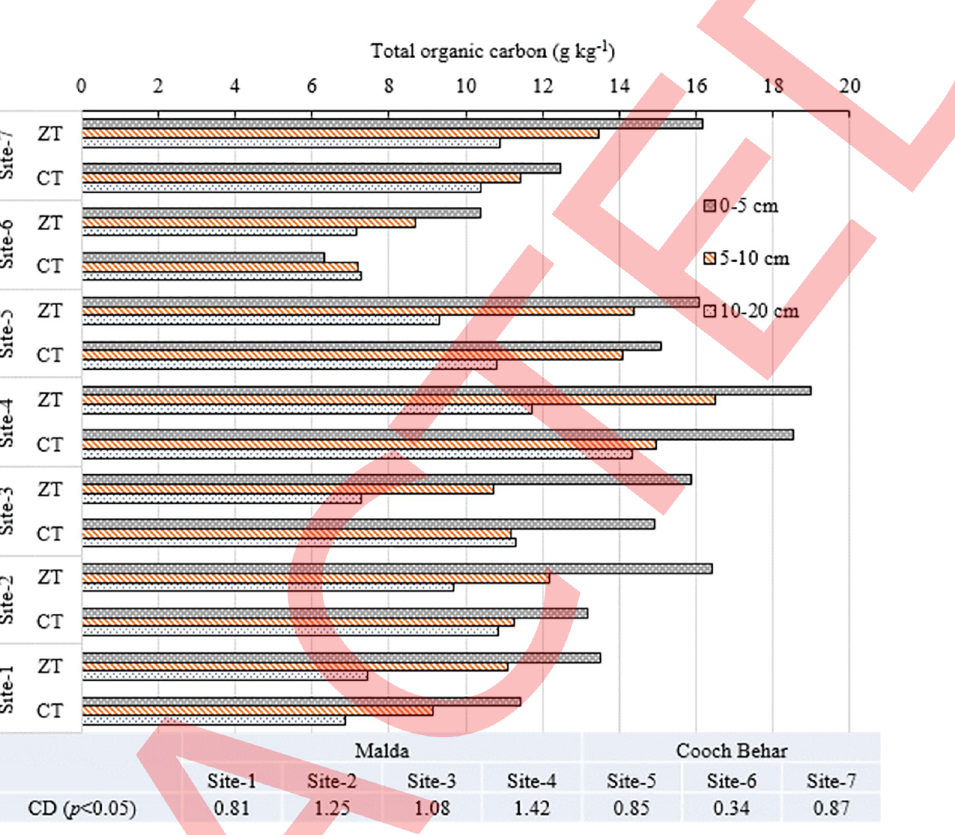
Fig 2. Effect of tillage system on TOC at different soil depths in the sites of Malda and Coochbehar.